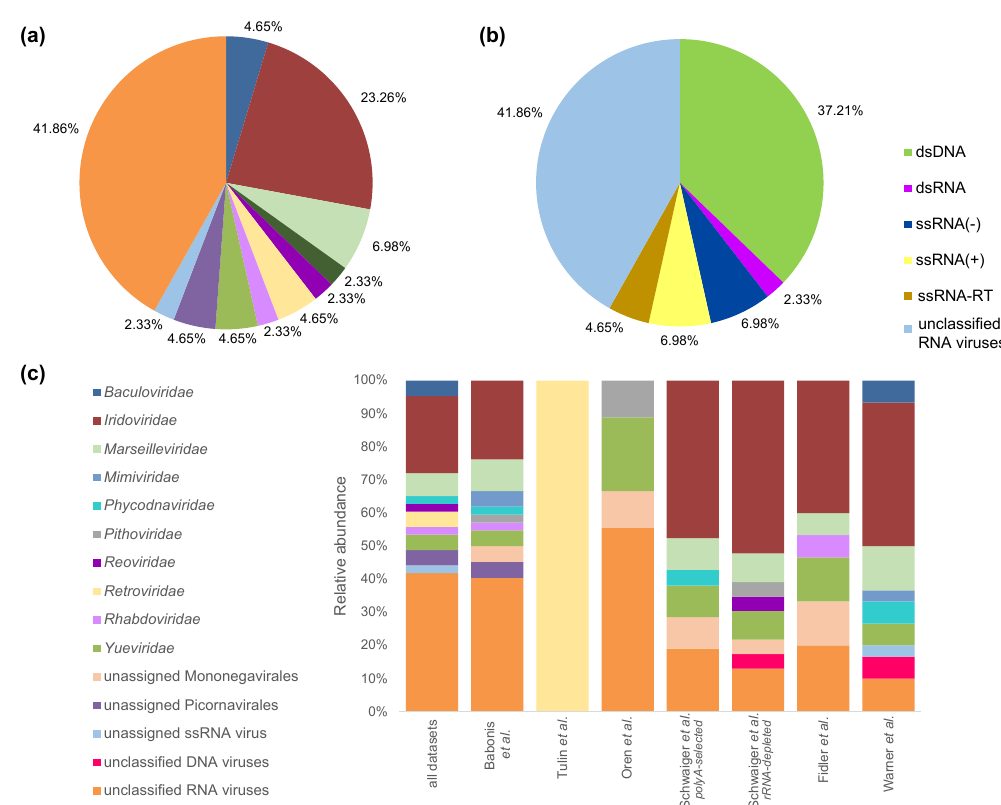
Figure 1. Taxonomic classification of N. vectensis viral sequences. Distribution of viral families ( a ) and groups ( b ) in the sequence assembly from all merged datasets and ( c ) relative abundance of viral families within each studied dataset. Sequences representing fragments of the same viral species were collapsed into one